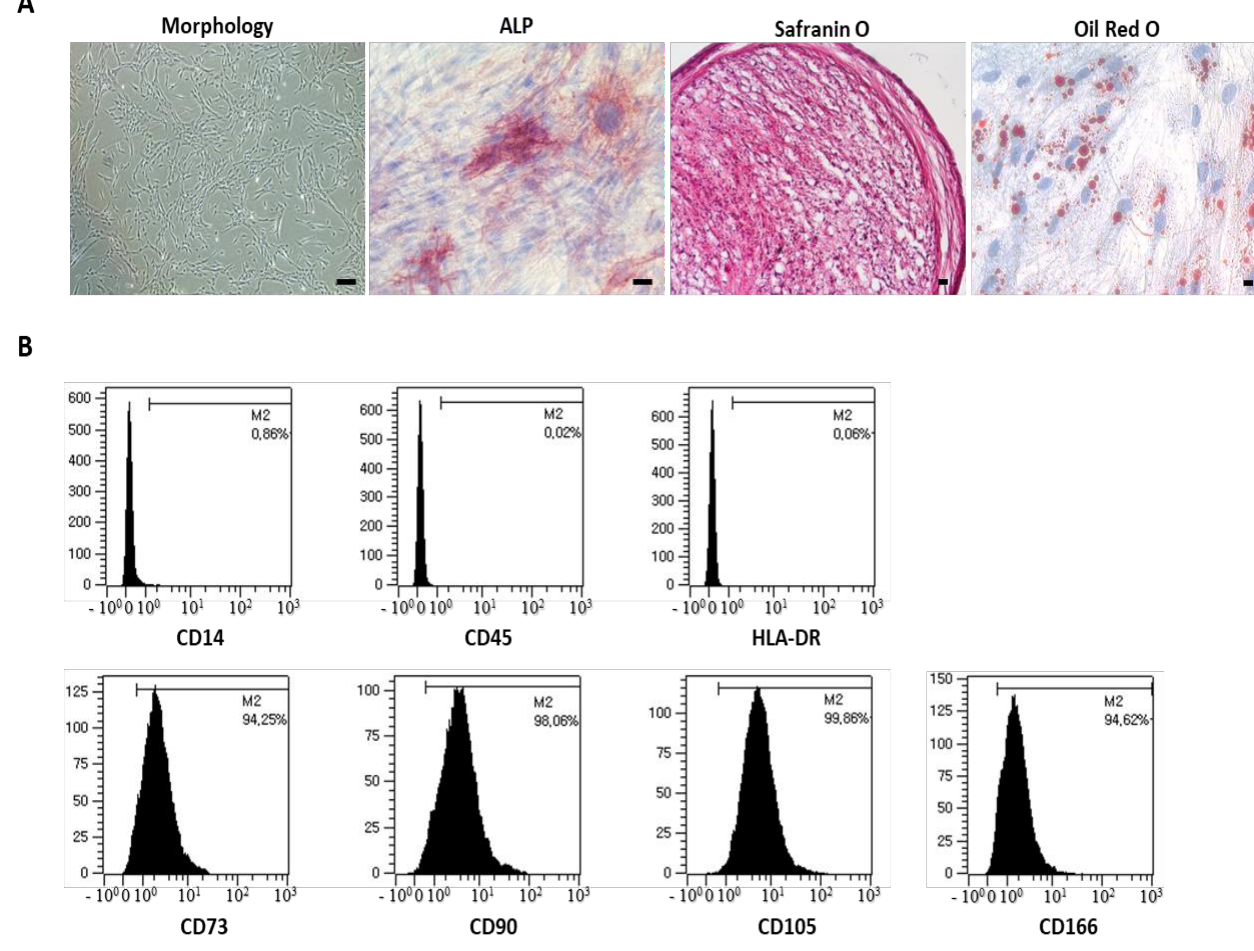
Figure 1. Characterization of MSCs at P6. ( A ) Morphological analysis shows adherent spindle- shaped cells. During incubation in a specialized induction medium, multilineage potential was demonstrated by staining typical multilineage markers. Osteogenic cells were analyzed based on ALP levels. Chondrogenic cells accumulated sulfated proteoglycans stained with Safranin O. Adipogenic cells exhibited increased lipid vacuoles within the cytoplasm via Oil Red O staining. Nuclei were counterstained with hematoxylin. Scale bar: 100 µ m. ( B ) Flow cytometric analysis of cells based on the cell surface expression of typical MSC markers. Cells were negative for CD14, CD45, and HLA-DR but strongly positive for CD73, CD90, CD105, and CD166. M2-related expression was noted.